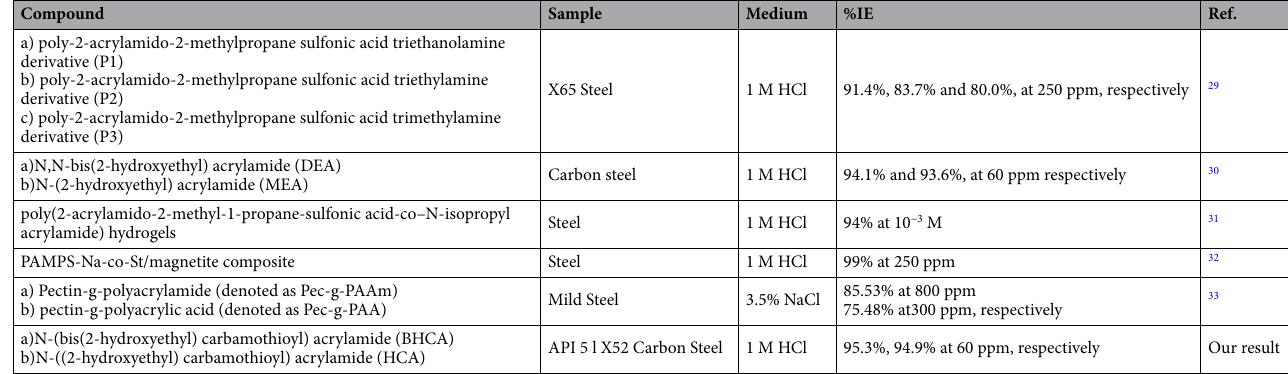
Compound Sample